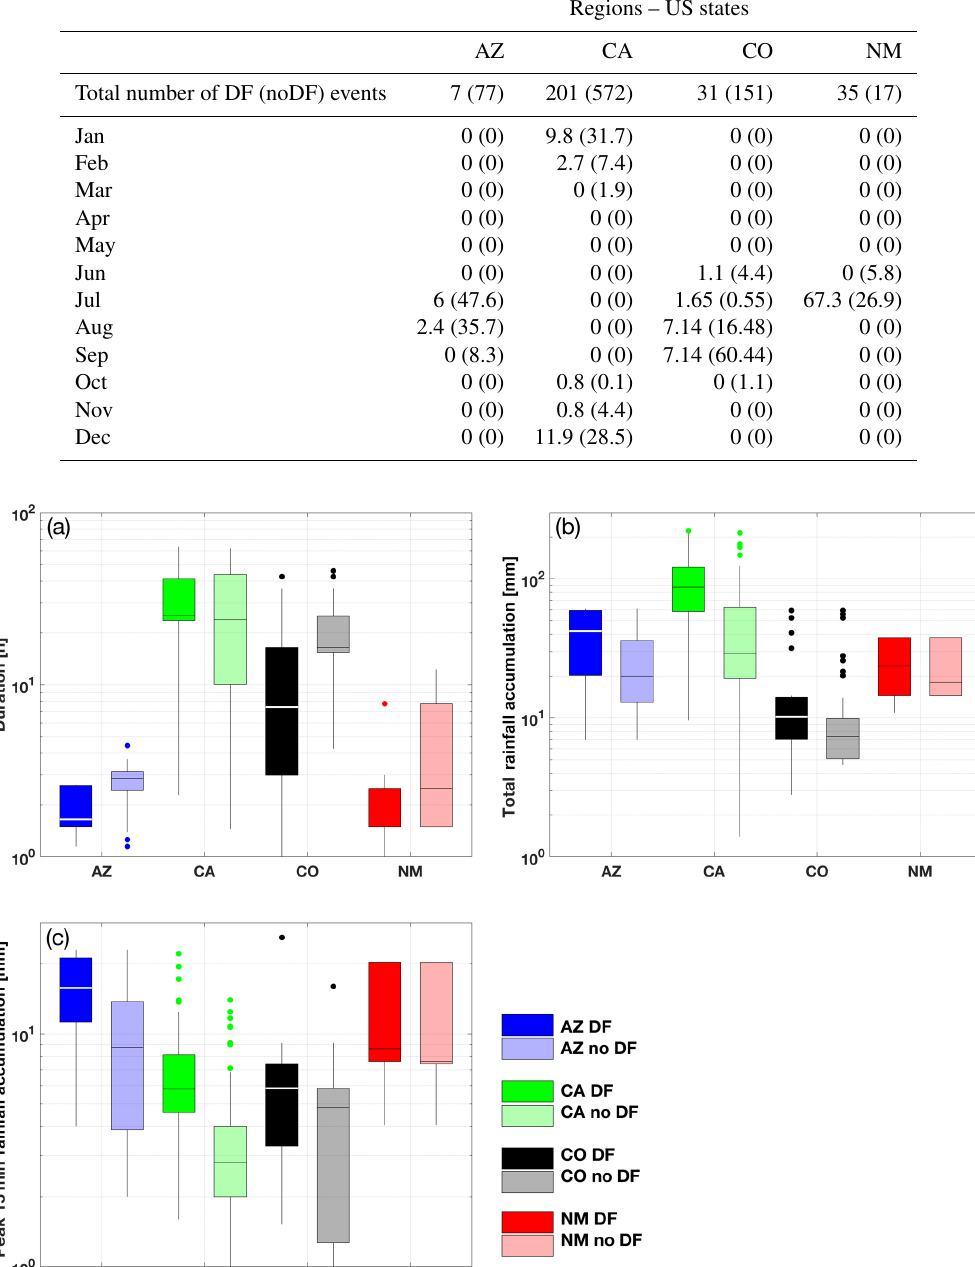
Table 2. Total number and monthly distribution of DF and noDF events analyzed for Arizona, California, Colorado and New Mexico. Values per month correspond to percentage (%) of the total number of events (DF + noDF) analyzed per region.